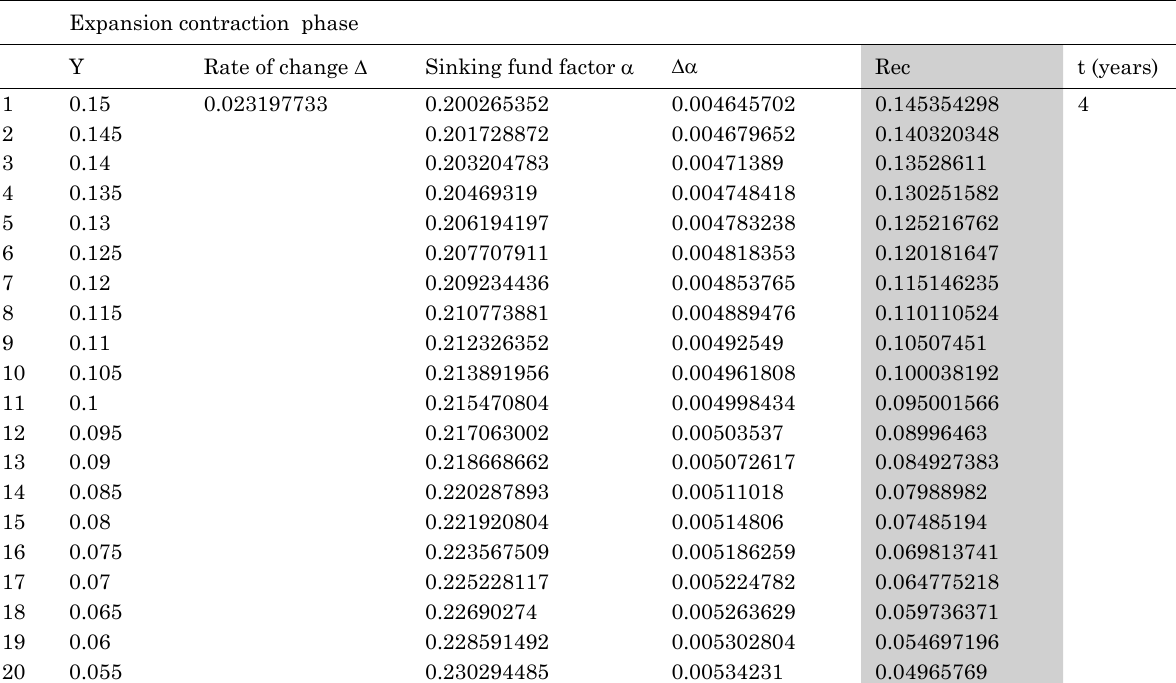
table 5. calculation of overall cap rate in the expansion contraction (+) phase expansion contraction phase